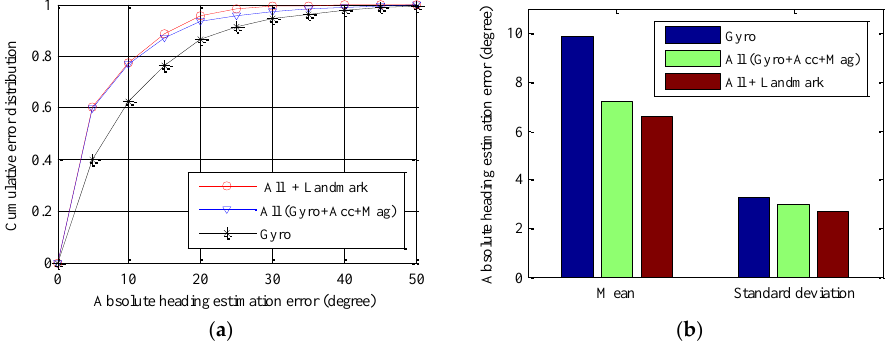
Figure 5. Performance comparisons of absolute heading estimation error of path one: ( a ) cumulative error distribution; and ( b ) mean and standard deviation.